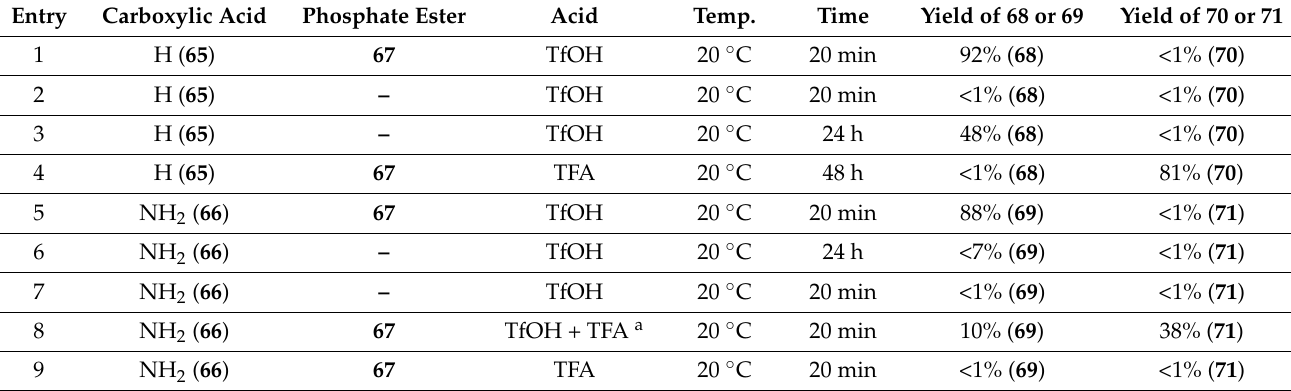
Table 1. Aromatic acylation with the aid of phosphoric acid triester 67